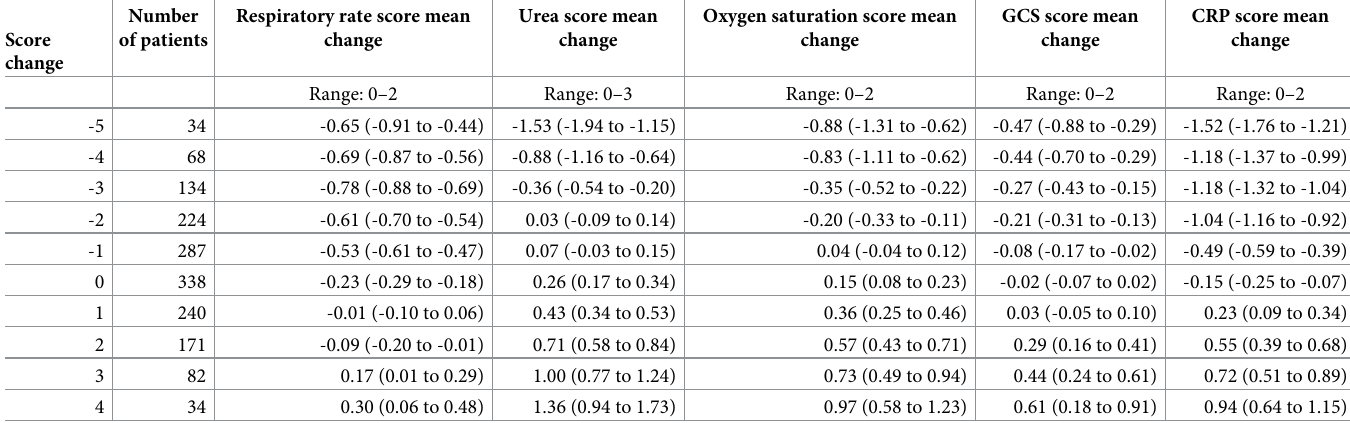
Table 4. Mean change (95%CI) in 4C components associated with an overall 4CD change between entry and day 8, in patients still in hospital at day 8.